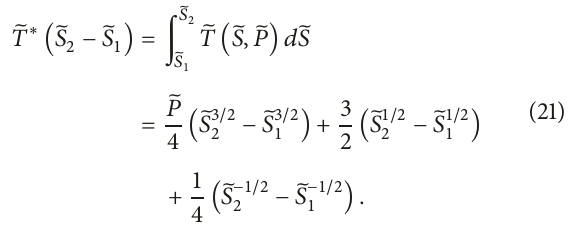
̃𝑇 ̃𝑆 ̃𝑃 = 0.7, 1.0,1.2 Figure 2: vs. for . The phase transition take place for oscillatory part. According to Maxwell’s equal area law, the phase transition point is